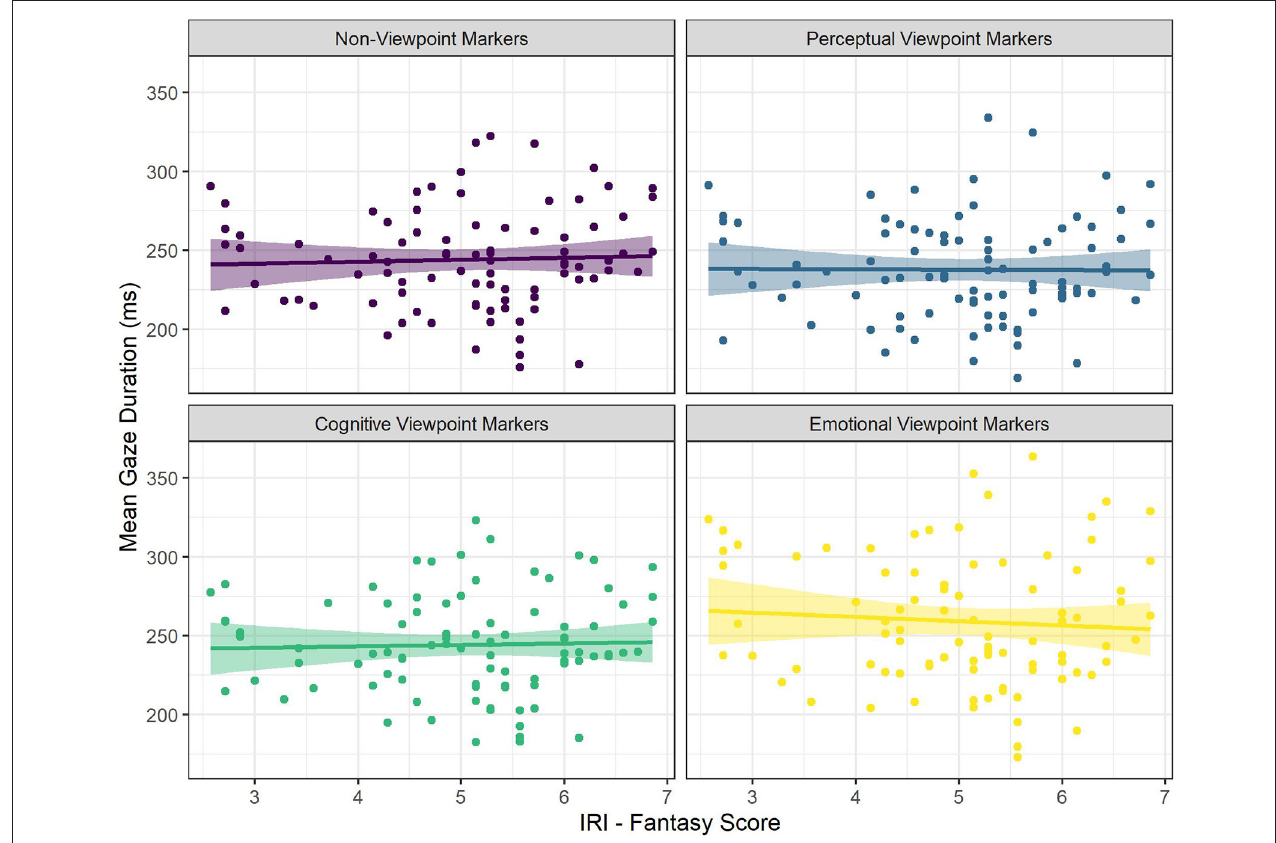
FIGURE 4 | The Relationship Between Mean Gaze Duration and IRI Fantasy Score for the Different Categories of Viewpoint Markers. Each Dot Represents a Participant.